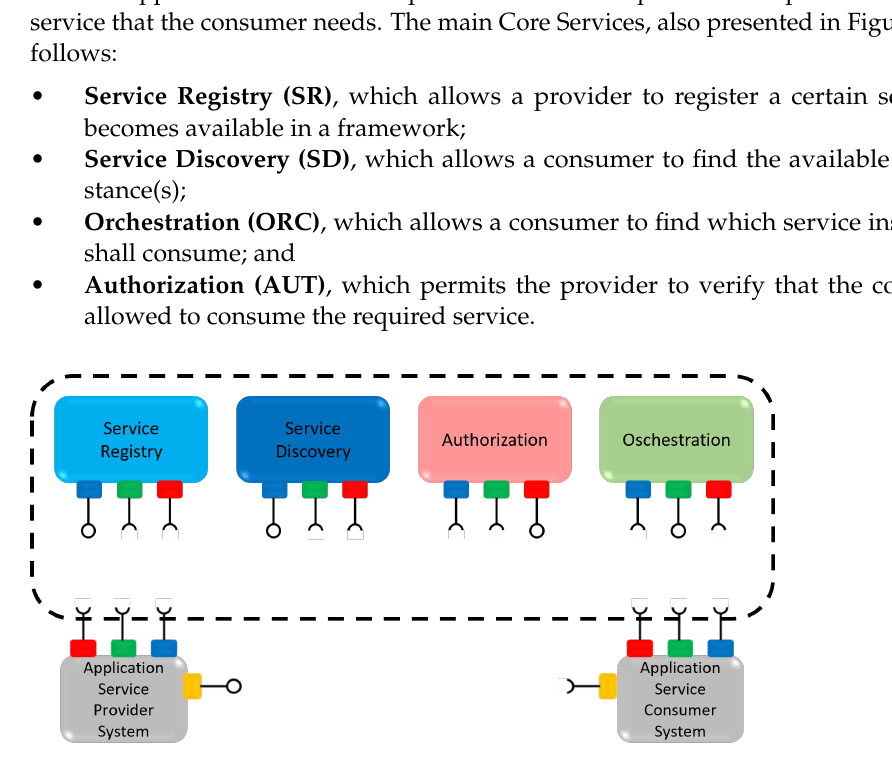
Figure 1. Arrowhead framework core services and application